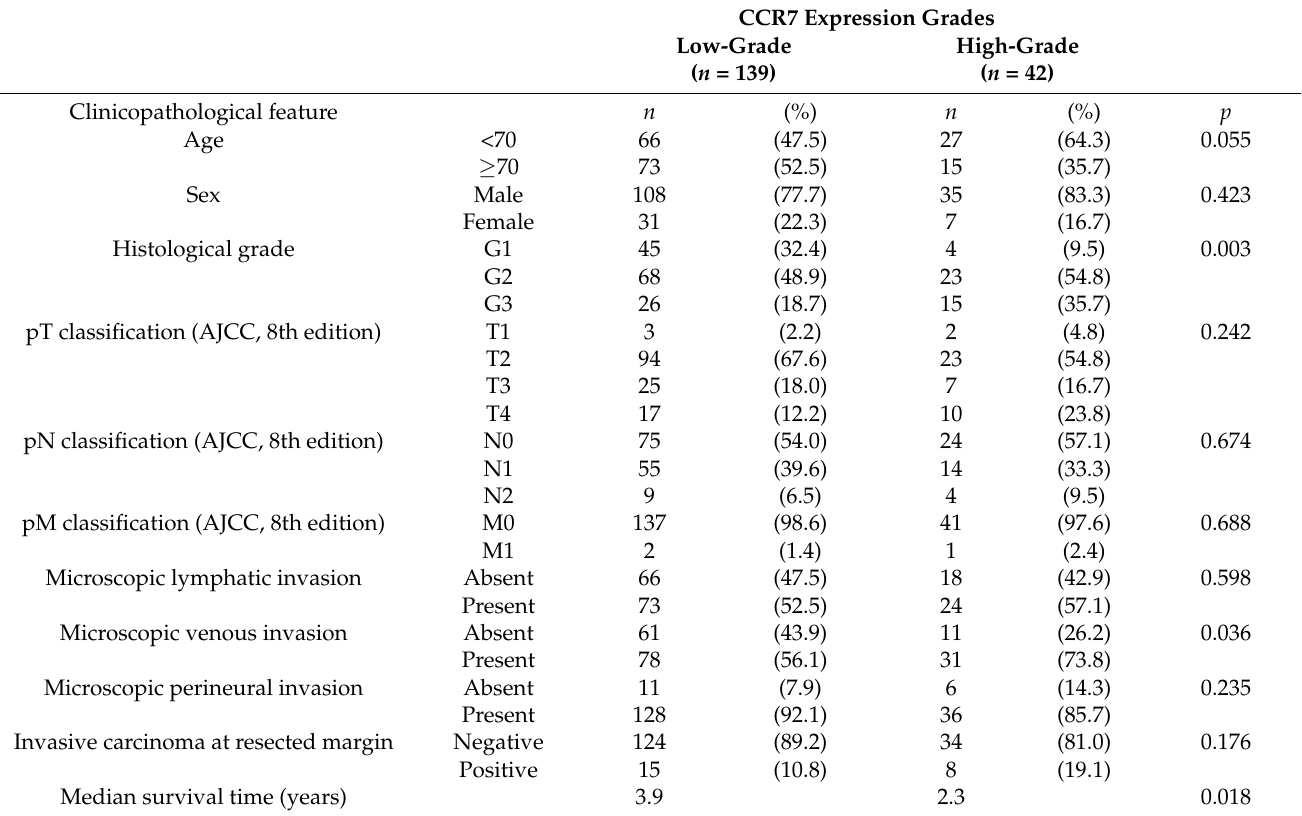
Table 1. Comparison of the clinicopathological features among patients with different CCR7 expres- sion grades ( n =